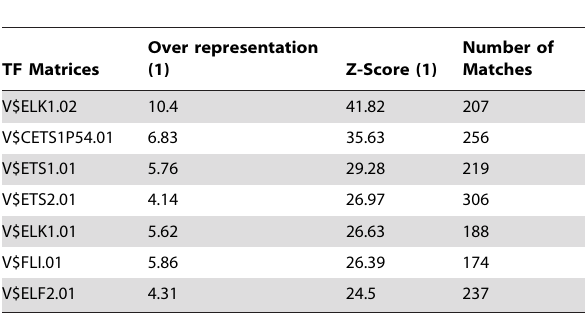
Table 2. Transcription factor consensus sites enrichment in regions other than GGAA